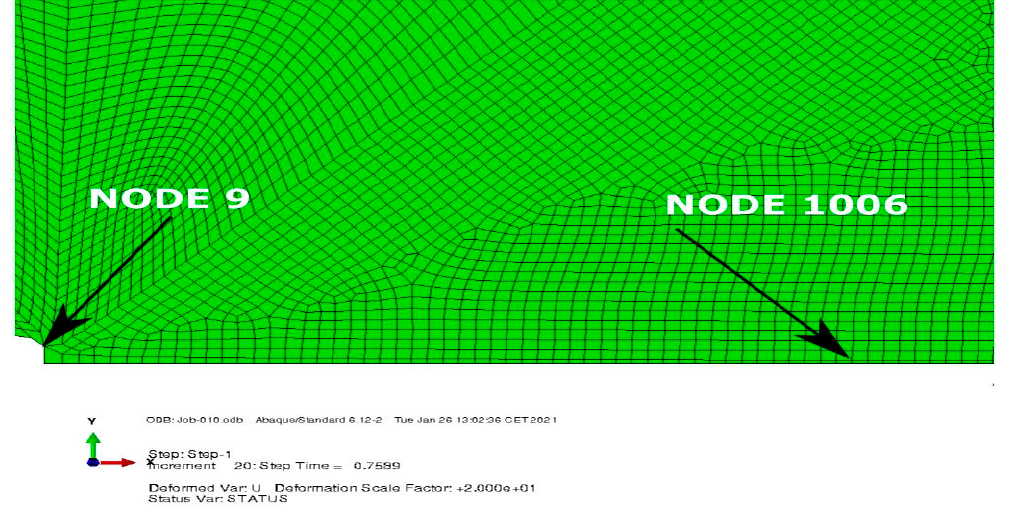
Figure 6 . J-integral changes for different constraint levels. Figure 6. J-integral changes for different constraint levels. The crack opening displacement (COD) and opening stress of the two nodes were analyzed (Figure 7). Materials 2020 , 13 , x FOR PEER REVIEW